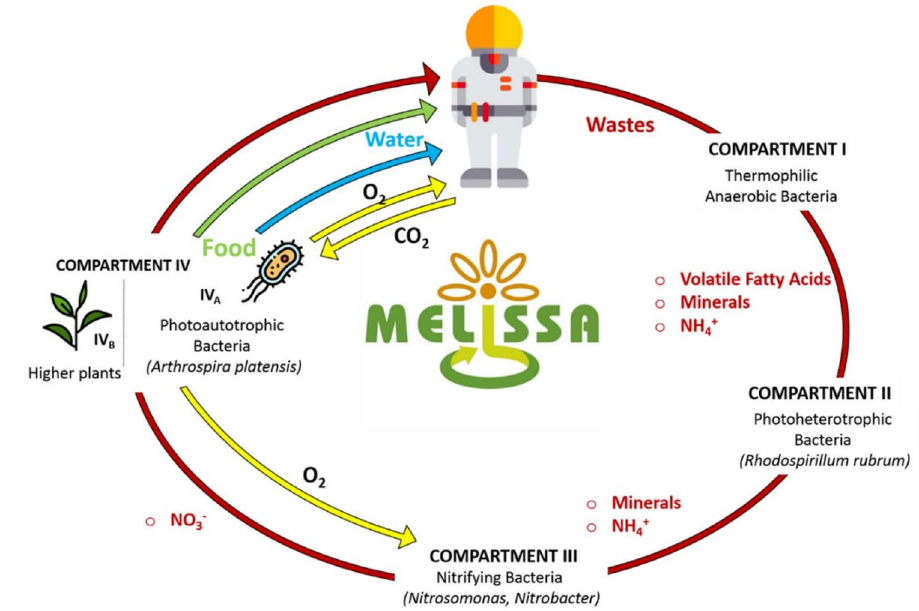
Fig. 12 Project MELiSSA BLSS cycle showing compartment 1 (liquefying compartment/ microbial fuel cell), compart- ment 2 (photoheterotrophic compartment), compartment 3 (nitrifying compartment / membraned aerated biofilm reactor), compartment 4 (photoautotrophic compart- ment), and compartment 5 (crew compartment) with flow process (reprinted with permis- sion from Ref. [16],